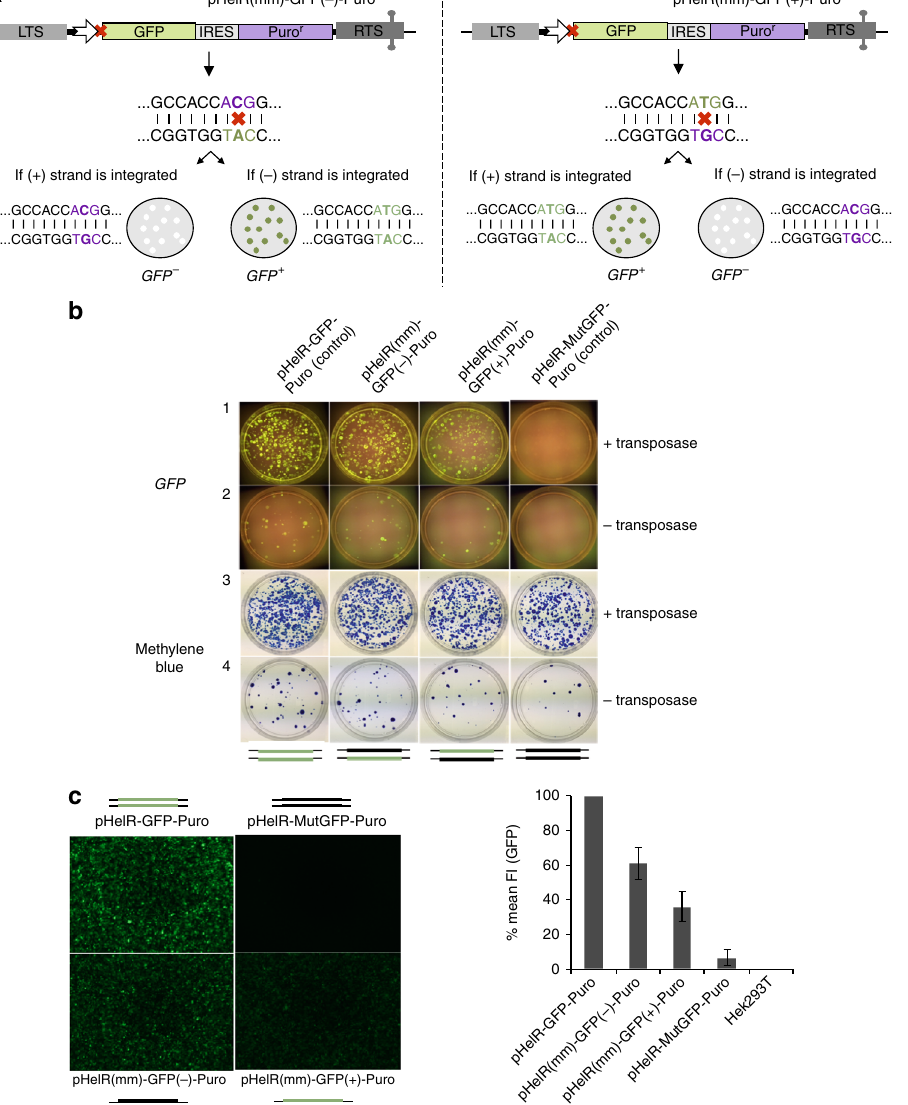
Fig. 4 Helraiser transposition from heteroduplex GFP-Puro reporter plasmids in HEK293T cells. a Schematic of relevant portions of Helraiser heteroduplex